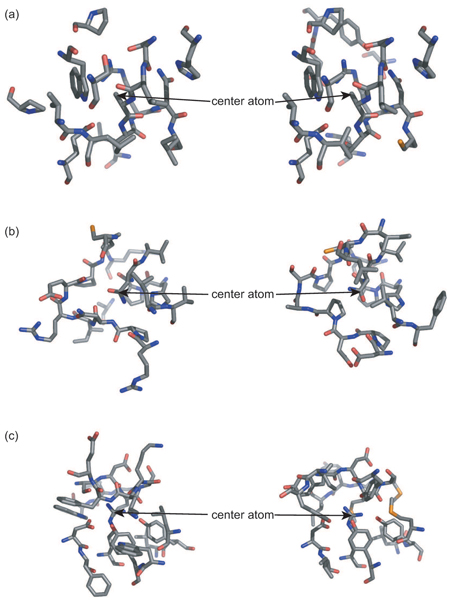
Structural examples of environments from validation clusters. Examples of pairs of environments from three of the validation clusters discussed in the text are shown. The structures were oriented by superimposing the PROSITE patterns, and the arrows indicate the atoms around which the microenvironments were centered. All residues containing atoms within the 7.5-Angstrom environment are depicted. The three comparisons show varying degrees of similarities among environments in the same cluster, ranging from nearly identical (a) to somewhat diverse (c). (a) The environments in the cluster containing residues from the PROTEIN_KINASE_TYR PROSITE motif are quite similar (top: PDB identifier 1fvr; bottom: 1luf). (b, c) The UBIQUITIN_CONJUGAT_1 (top: 1ayz; bottom: 1wzv) and STAPH_STREP_TOXIN_2 (top: 1aw7; bottom: 1ck1) clusters show greater degrees of structural variability. These images were produced using PyMol [28].